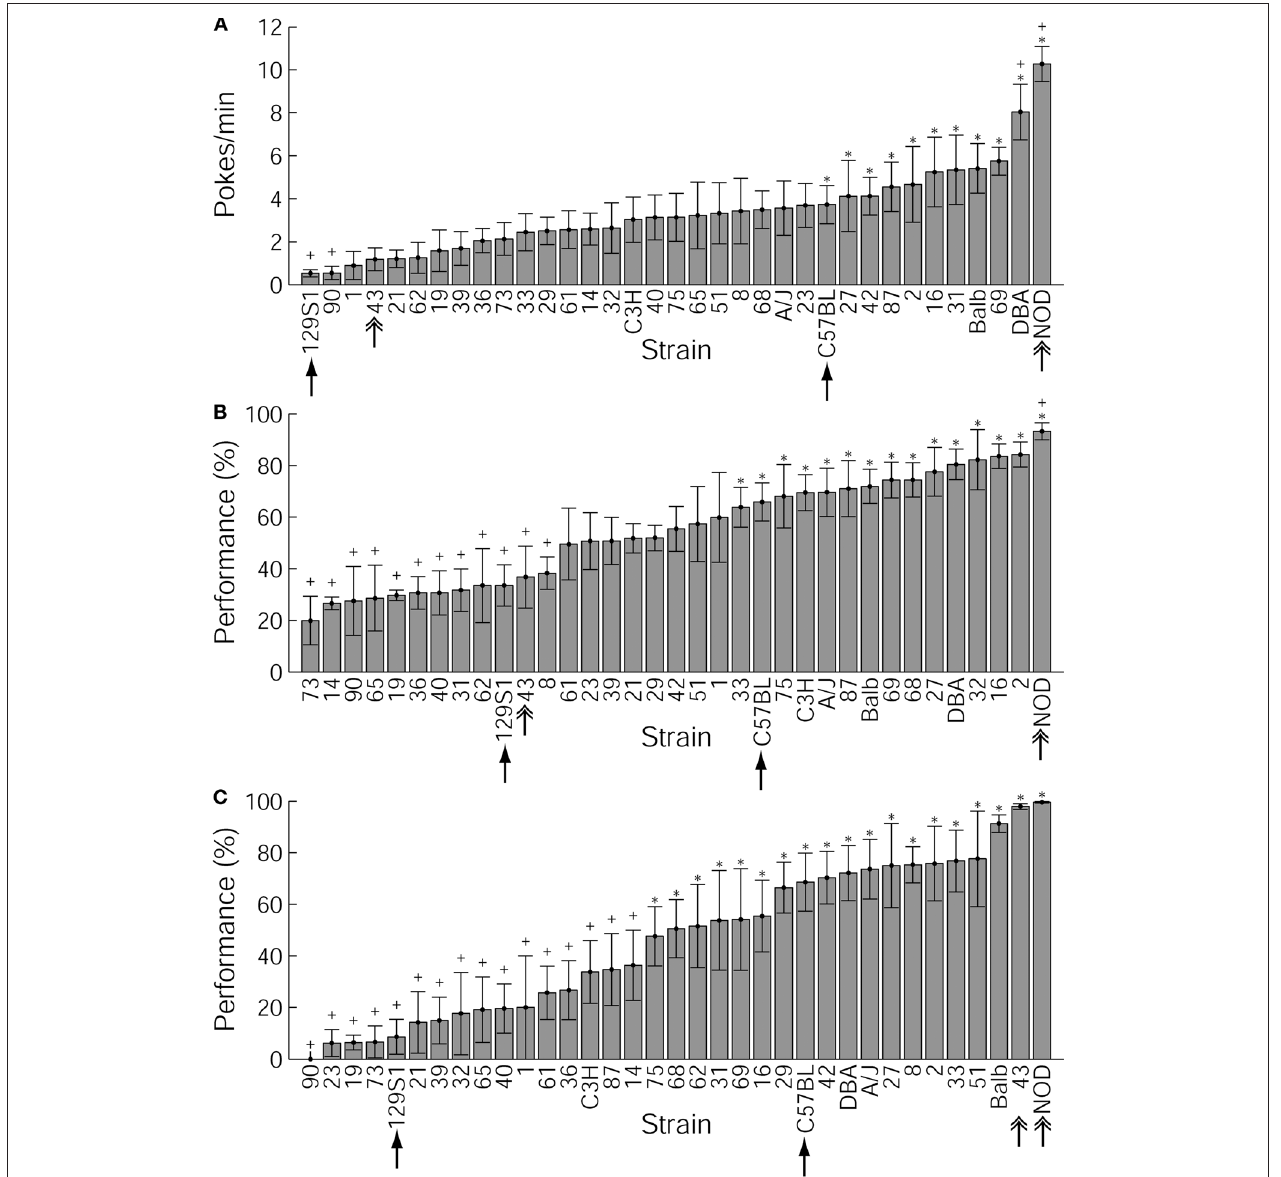
Figure 2 | Variability of behavioral parameters across the 35 strains tested. C57BL/6J and 129S1/Sv are indicated with simple arrows. Mouse lines significantly different from C57BL/6J and 129S1/Sv are indicated with a plus sign and an asterisk, respectively. NOD/Ltj and BxD-43 (discussed in the text) are indicated with double arrows. (A) Initial magazine checking behavior at the beginning of the first session of training. Initial magazine checking behavior is presented by the number of nose pokes in the food magazine per minute of intertrial interval during the first 10 trials of the first session of behavioral